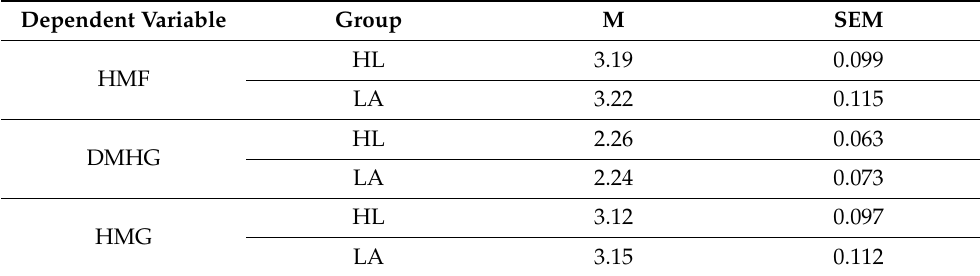
Table 5. Milking speed traits (kg/min) of cows by health status and lameness level ( n = 0.128). Dependent Variable